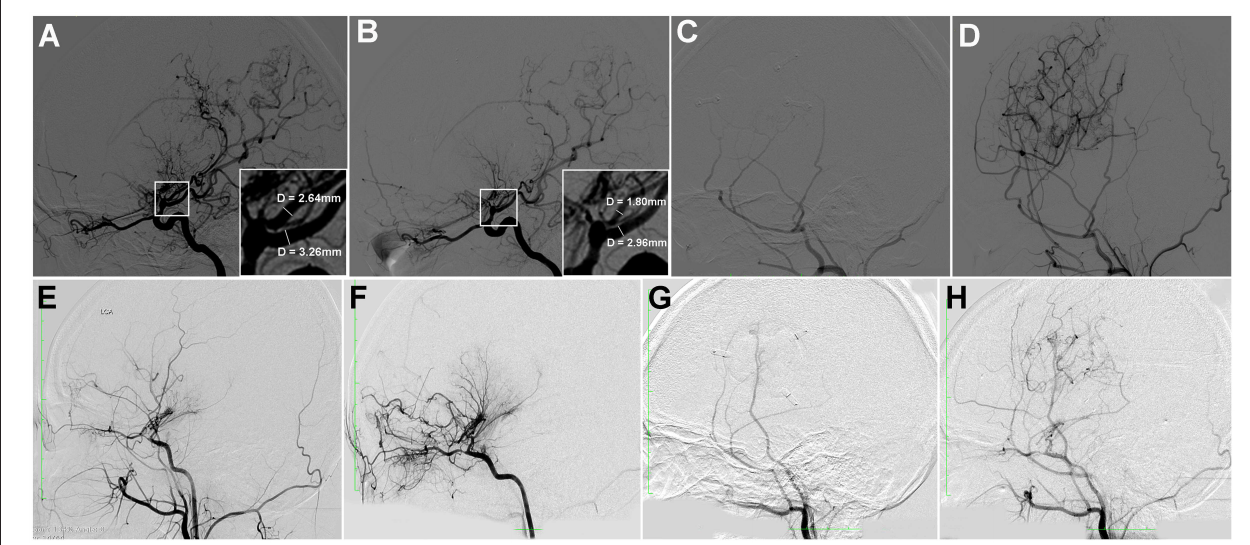
FIGURE 3 | Two cases of hemorrhagic MMD with direct or indirect revascularization. (A–D) A 20-year-old female patient with hemorrhagic MMD, who received direct revascularization. Preoperative DSA showed dilation of AchA and PcomA (A) . Postoperative DSA a year later showed significant regression of dilated AchA and PcomA (B) , with substantial revascularization collaterals (C,D) . She was followed-up for 56 months without rebleeding. (E–H) A 19-year-old female patient with hemorrhagic MMD, who received indirect revascularization. Preoperative DSA showed mild dilatation of AchA (E) . Postoperative DSA a year later showed that the regression of dilatated AchA was not significant (F) , with moderate revascularization collaterals (G,H) . She was followed-up for 48 months without